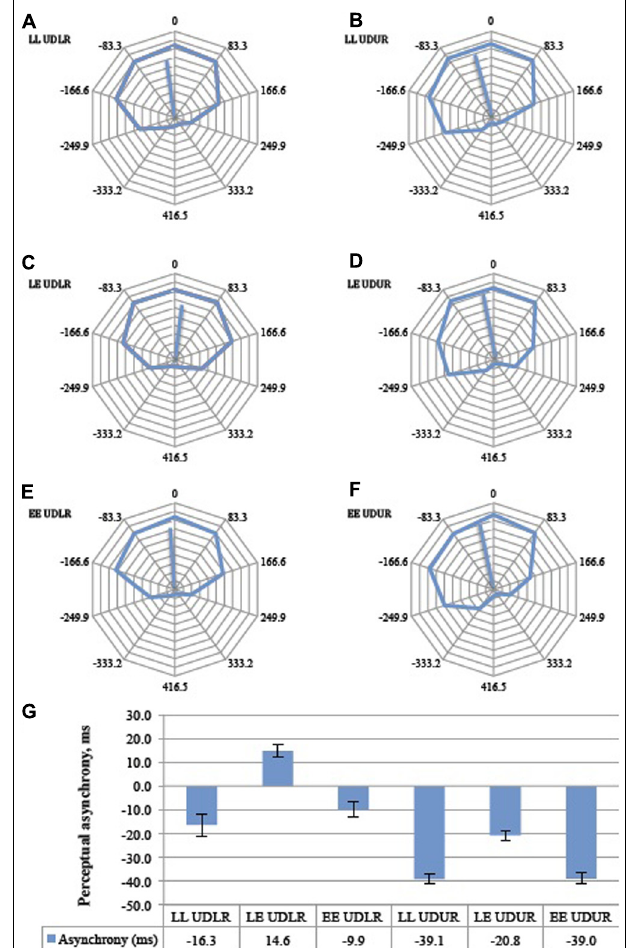
FIGURE 7 |The aggregate response curves for all 11 subjects for the six trial types (A–F). 360 ◦ represents a period of 833 ms, and each 36 ◦ division represents 833 ms.The average angular shifts are summarized in a bar graph (G) . Error bars represent the standard error of the mean. LL = luminant vs. tummant, LE = luminant vs. equiluminant, EE = equiluminant vs. equiluminant. UDLR = up–down vs. left–right , UDUR = up–down vs. up–right